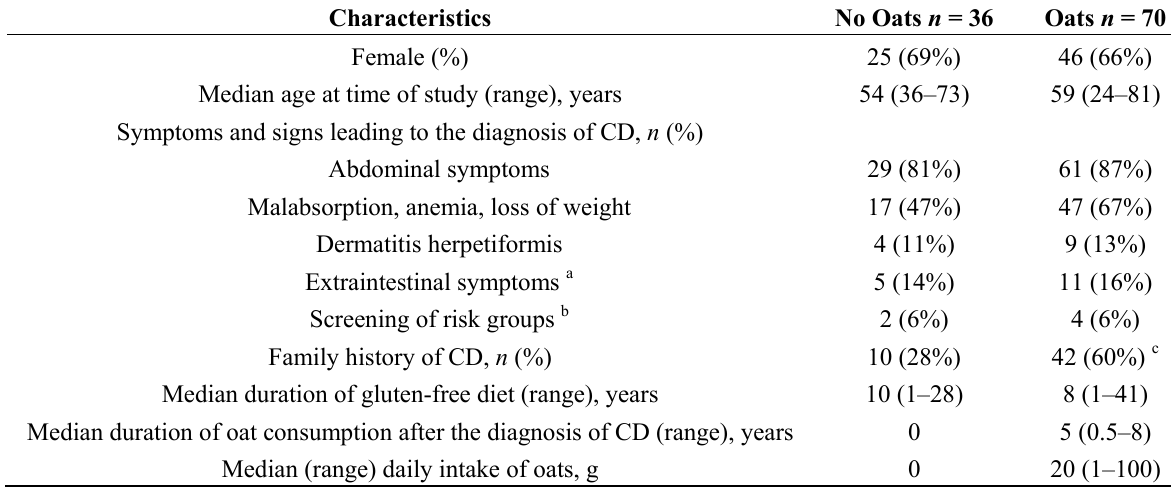
Table 1. Demographic data and dietary history in 106 treated celiac disease (CD)